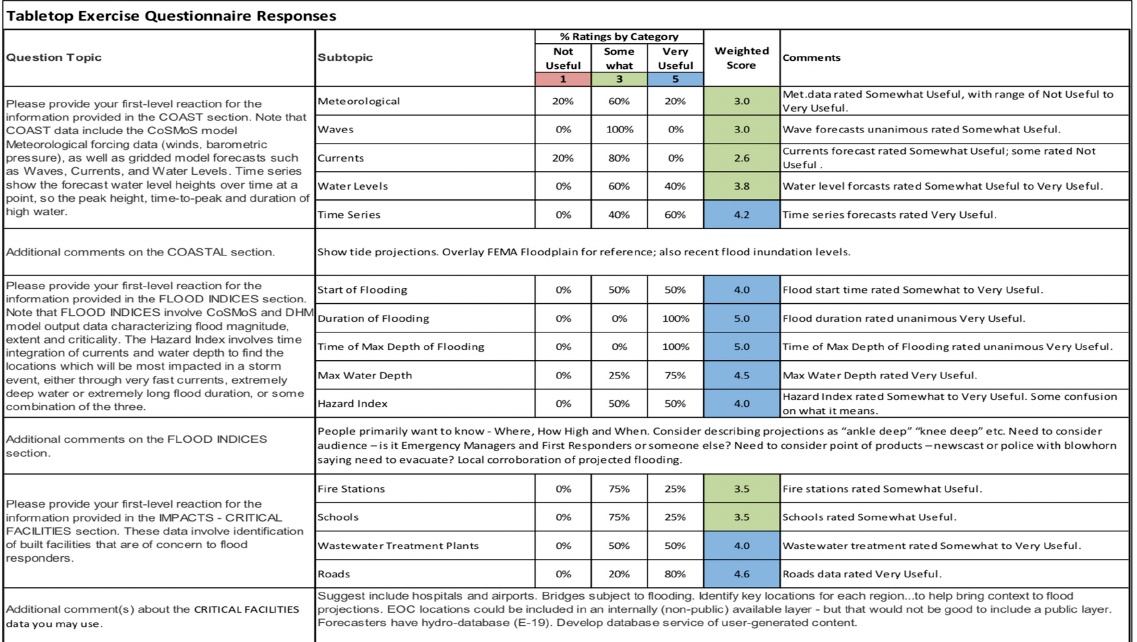
Table 3. Summary of TTE questionnaire responses for coastal flooding